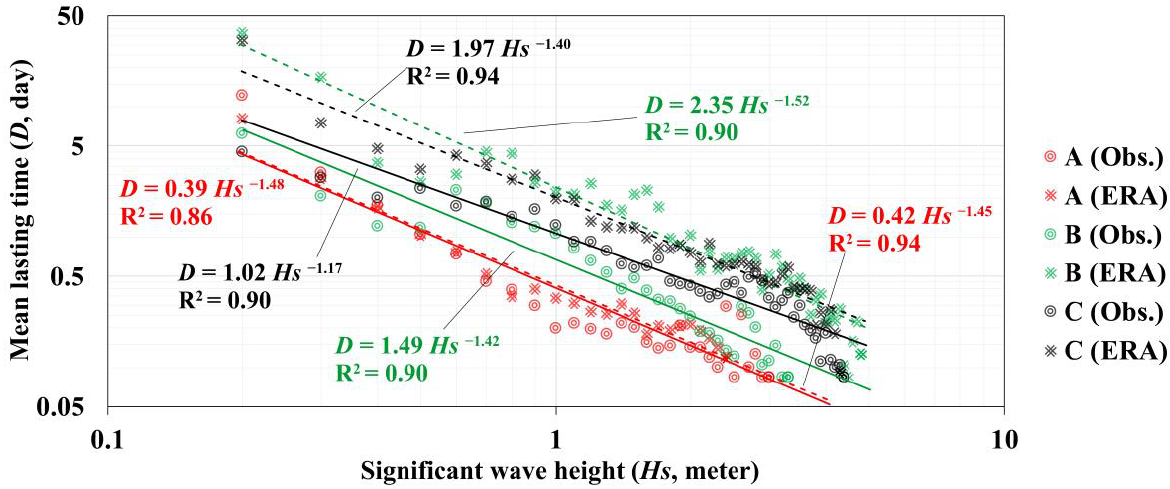
Figure 5. Variation in mean lasting duration ( D ) of different significant wave heights ( Hs ) calculated from ERA5 model output and in situ observations.